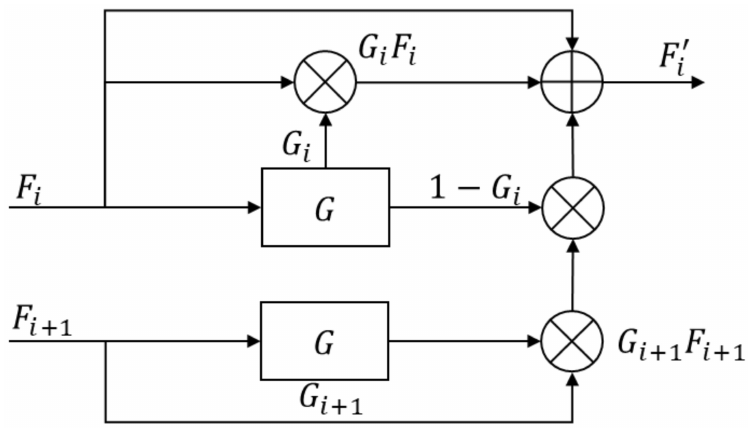
Figure 5. Structure of the gated fusion